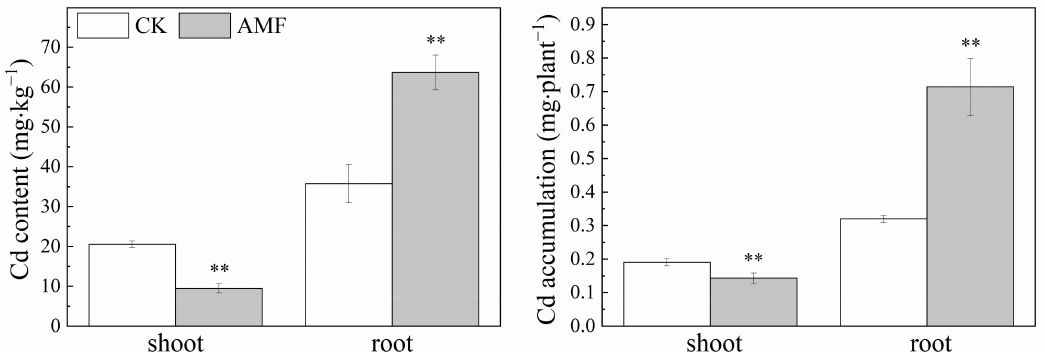
Figure 4. Effects of AMF on Cd content and uptake in maize plant under two Cd concentration stress. Error bar indicates standard deviation, n = 4. CK represents the control of non − inoculation, Cd represents cadmium. AMF represents Funneliformis mosseae inoculation. “**” mean p < 0.01 according to the LSD test.